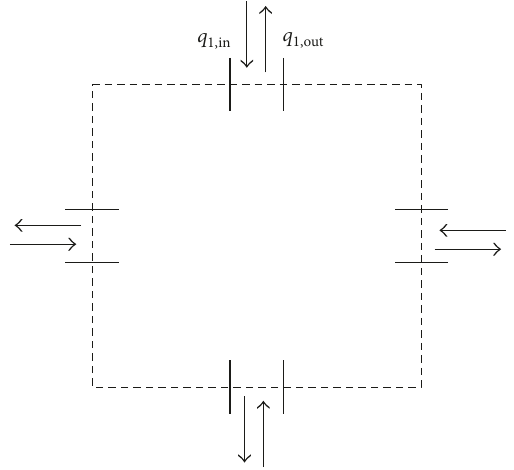
Figure 1: Visualisation of the theoretical